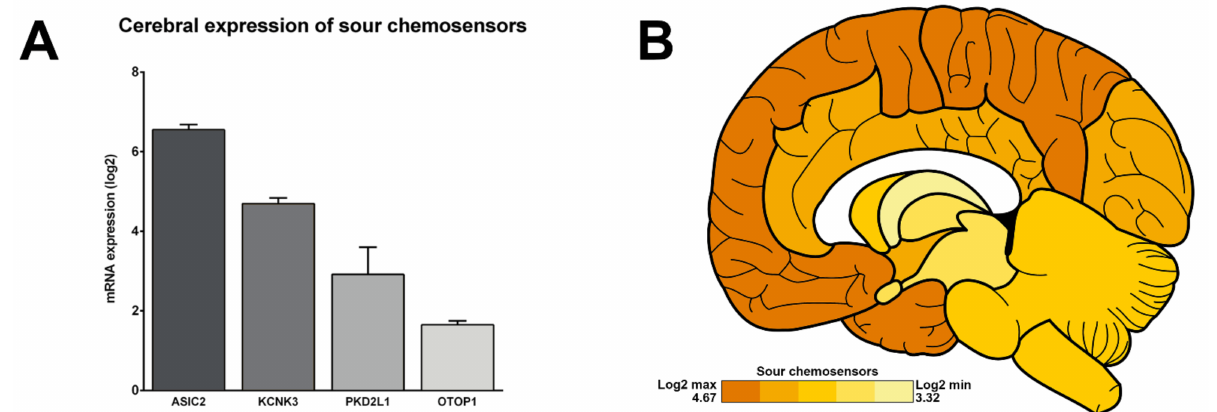
Figure 4. Expression of sour chemoreceptor genes in the human brain. ( A ) Histogram showing the average expression of ASIC2, KCNK3, PKD2L1 and OTOP1 in the whole brain of a 31-year-old Caucasian male. ( B ) Regionalised mean expressions of described sour chemosensor candidates in the brain of the same subject. The maximum and minimum log2 values are indicated in the bottom left